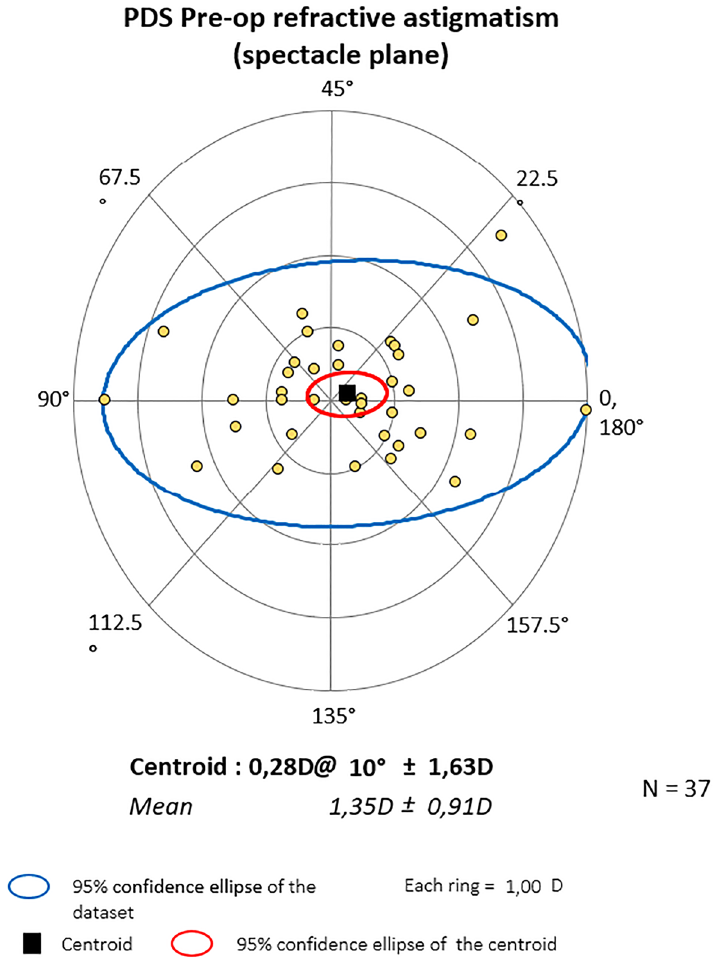
Figure 6. Preop astigmatism on the double angle plot PDS. The trend is ATR. The yellow dots represent a single subject’s